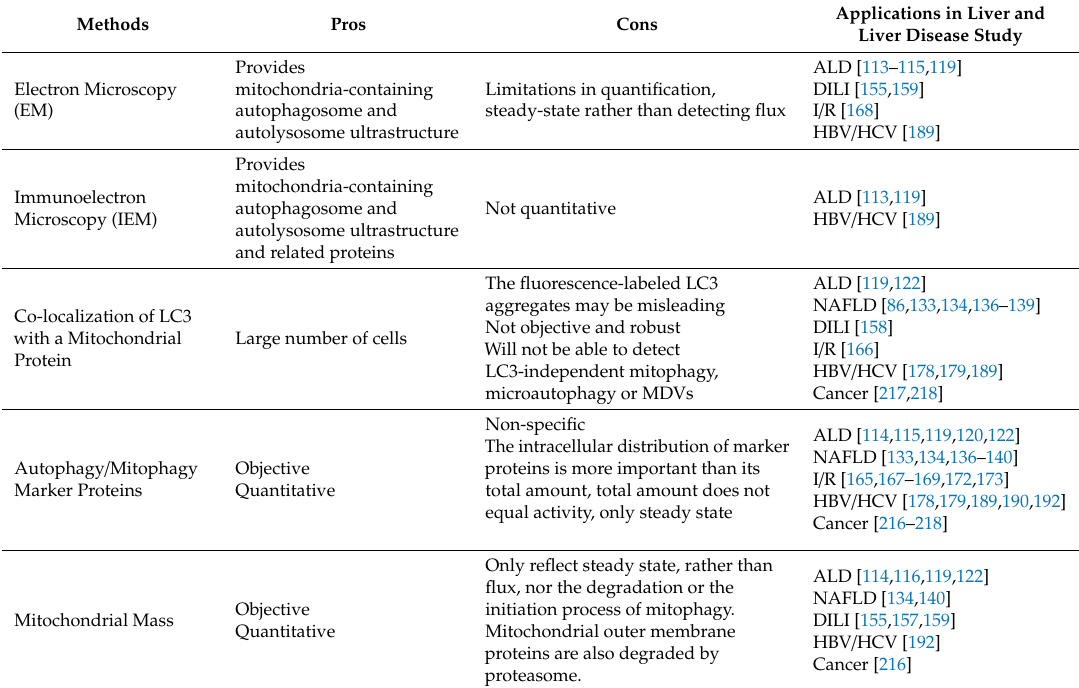
Table 2. Methods monitoring mitophagy in liver